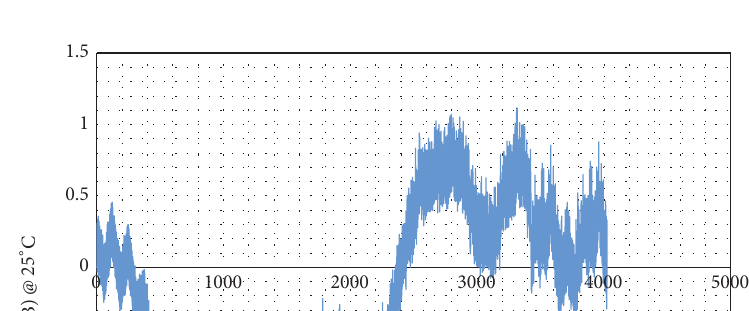
Figure 12: DNL at 125 ∘ C.